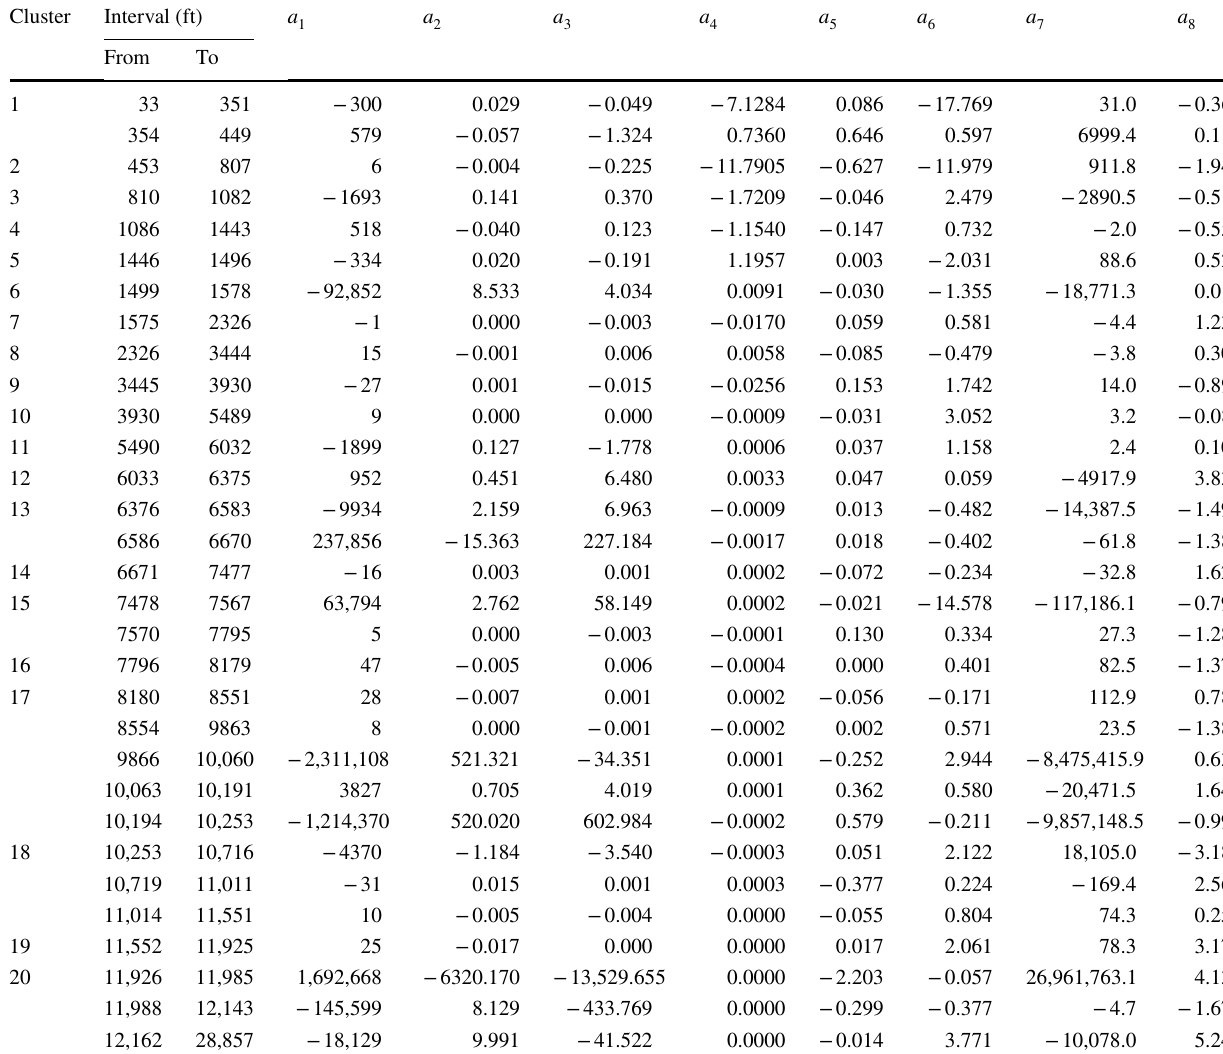
Table 6 Multiple regression analysis result for coefficient values Cluster Interval